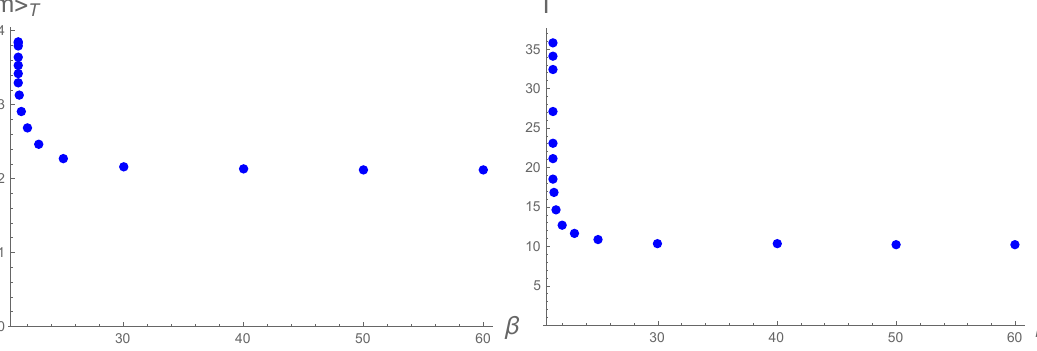
Figure 14 . Average mass h m i (left) and period T (right) of the time-periodic solutions generated T by the build-up phase when (cid:12) > (cid:12) c